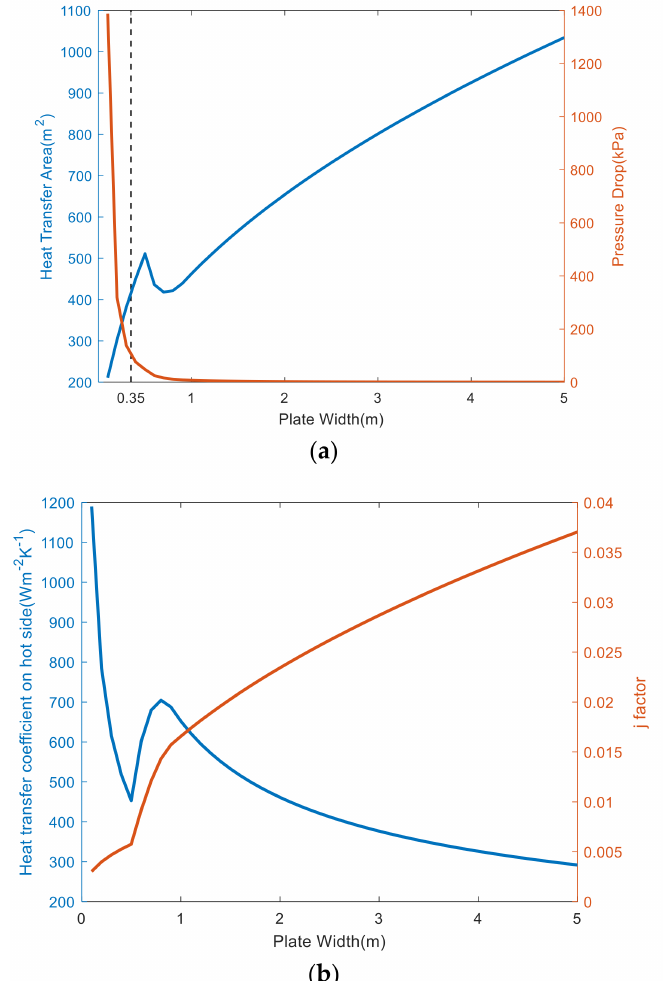
Figure 6. Effect of plate width on heat transfer area and pressure drop of PFHE. ( a ) Heat transfer area, ( b ) heat transfer coefficient on hot side.